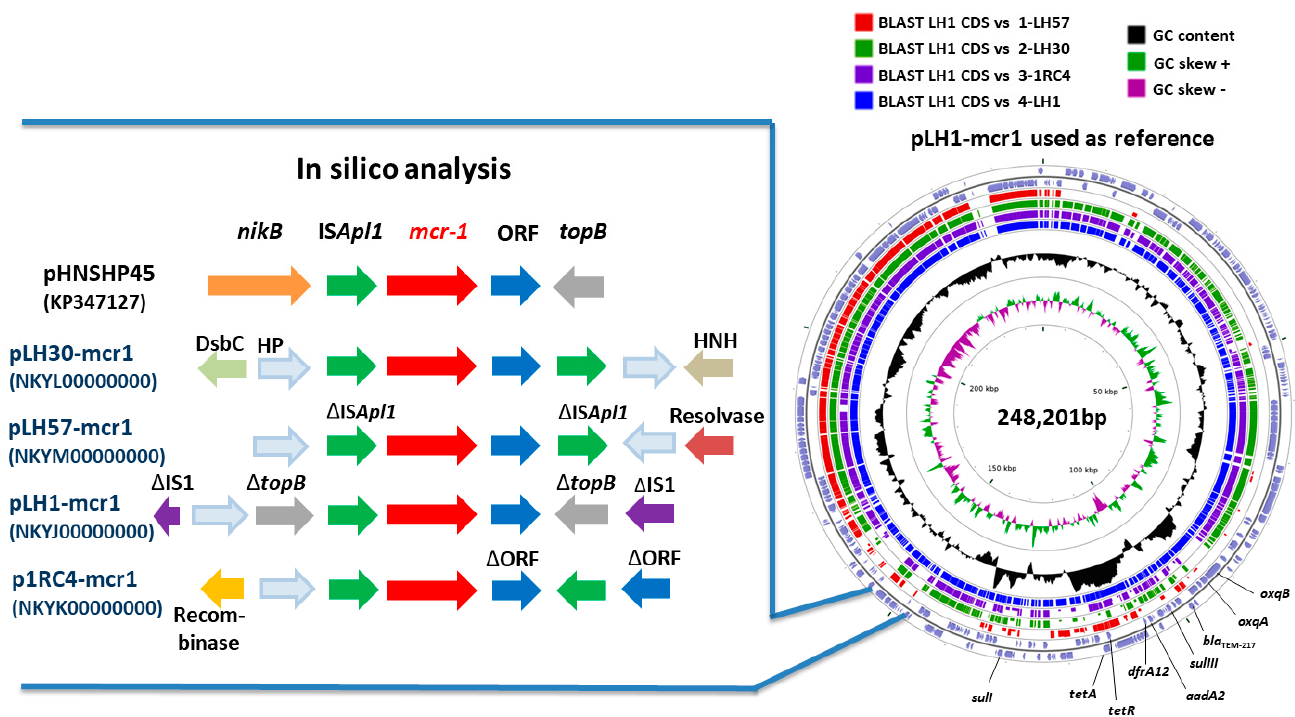
Figure 3. Genetic environment of the mcr-1 gene in plasmids: pHNSHP45 (KP347127), pLH30-mcr1 (NKYL00000000), pLH57-mcr1 (NKYM00000000), pLH1-mcr1 (NKYJ00000000), and p1RC4-mcr1 (NKYK00000000). Comparison of the four complete mcr-1 plasmids was performed using blastP with CGview software. nickB refers to Nickel B, topB : topoisomerase B, DsbC: Thiol:disulfide interchange protein DsbC, HP: Hypothetical protein, HNH: HNH endonuclease, IS: Insertion sequence.